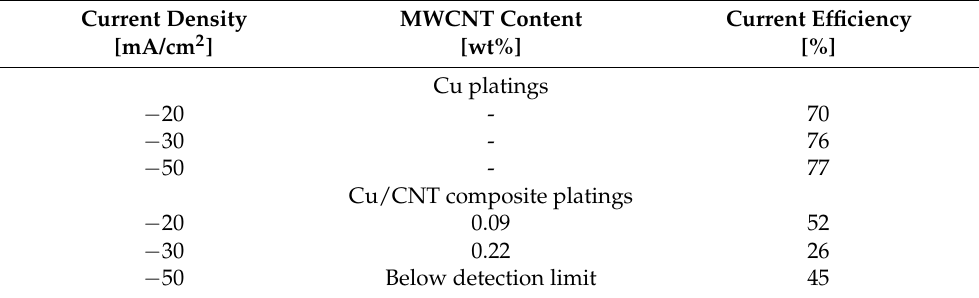
Table 1. CNT contents and current efficiency of Cu/CNT composite platings prepared by pulse electrolysis at various current densities (stirring rate: 250 rpm, CNT concentration of bath: 1.0 g/L, duty ratio: